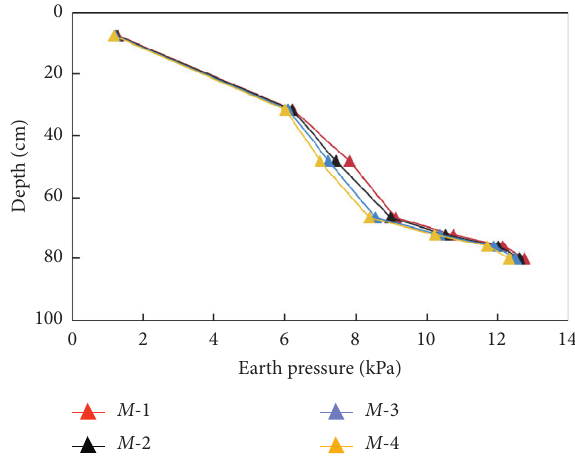
Figure 20: Earth pressure behind the wall of 0.36H.